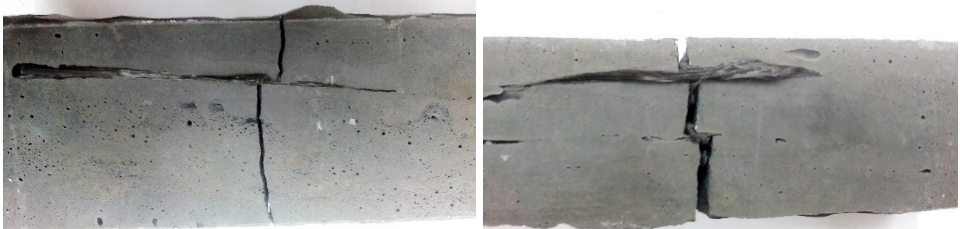
Figure 11. Cracking of fly ash composites reinforced with 1.0% carbon fiber roving additive—a visible mechanism of the reduction of crack propagation through the fibers.